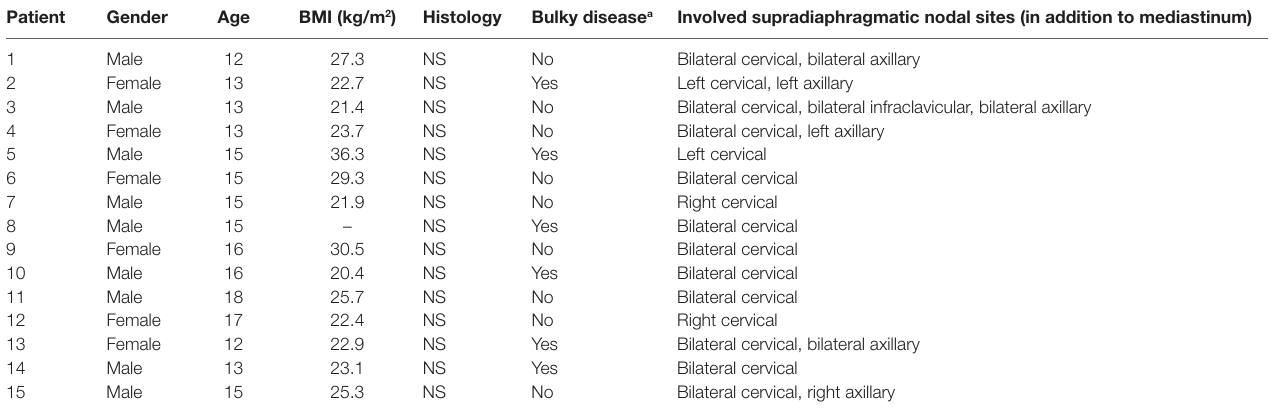
TaBle 1 | clinical characteristics of the study population.